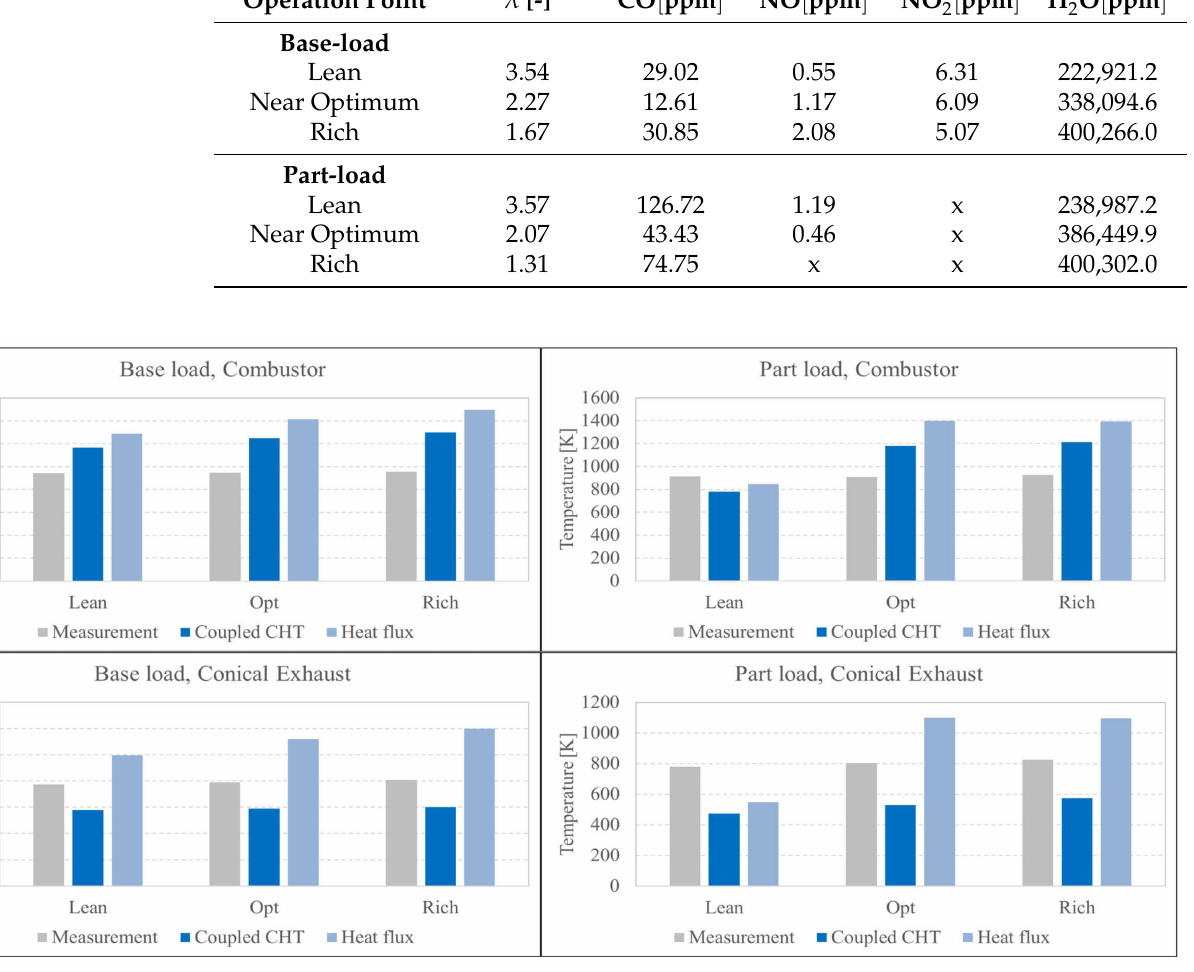
Figure 10. Pointwise temperature measurements and comparison with numerical results for the coupled CHT and heat flux modeling. Combustor: Downstream in the combustor strut. Conical Exhaust: Mid-height on the conical exhaust section wall. Measurement uncertainties in Table 3. Measurement standard deviation: ± 0.01 °C. Table 3. Uncertainties of temperature and CO emissions measurements (thermo-couples)